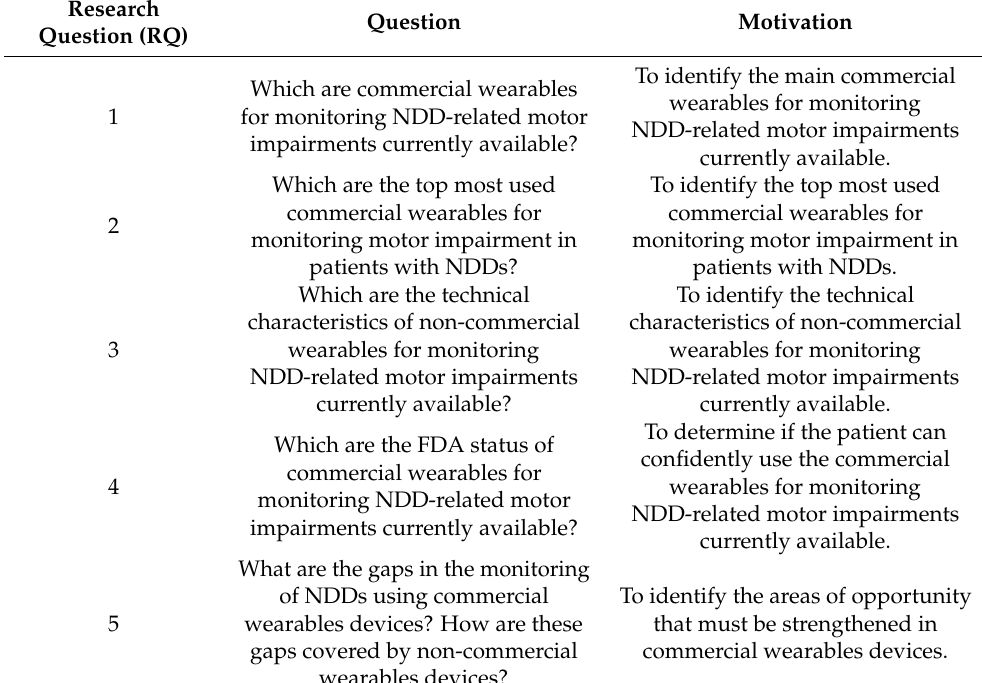
Table 1. Research Questions.